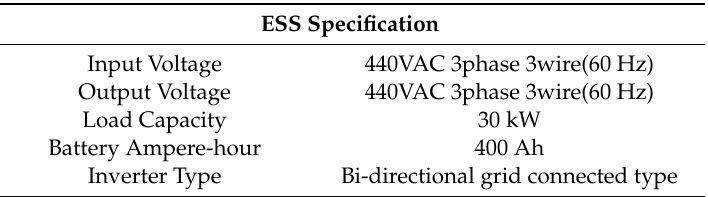
Table 2. Specification of ESS.